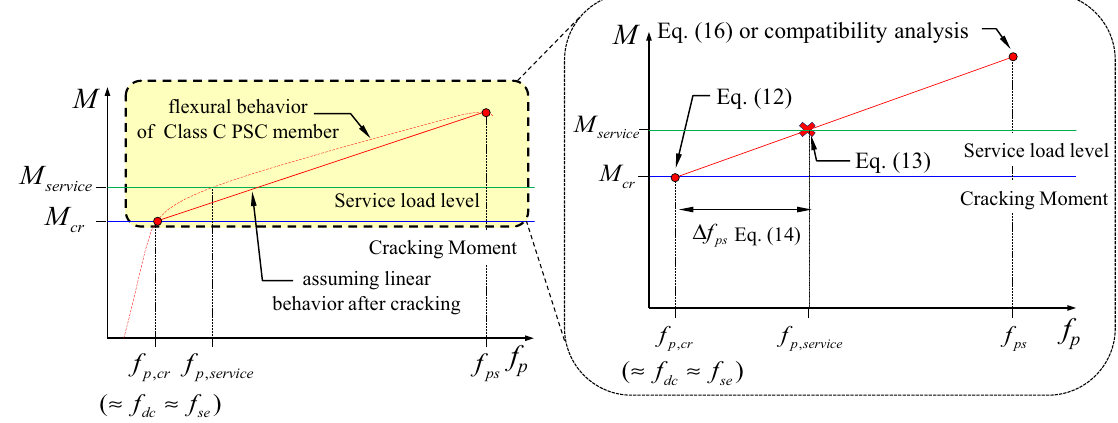
Fig. 14 Concept of the simple method to calculate D f ps.